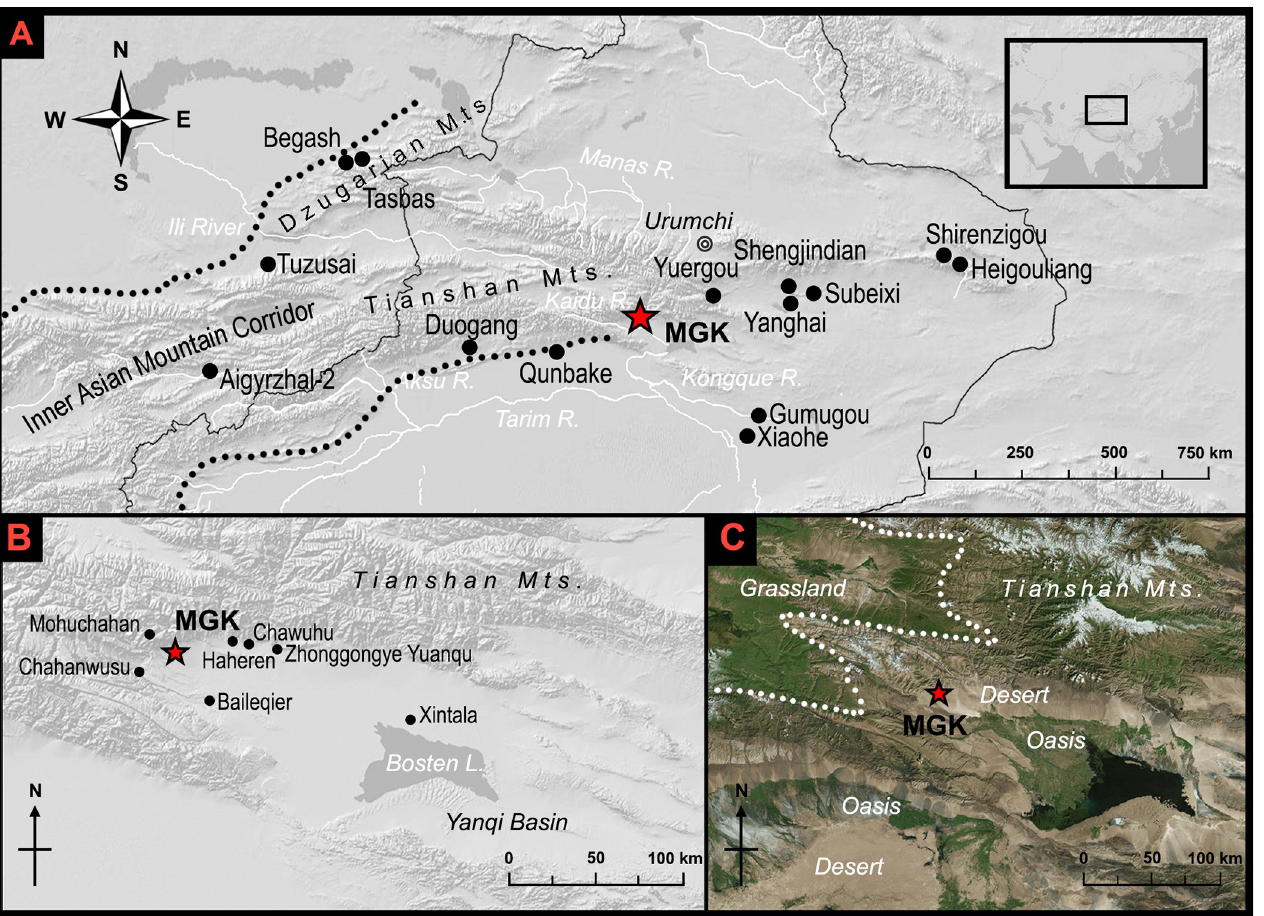
Fig 1. Location of MGK. (A) Location of MGK and other sites mentioned or cited in this article (except for those in the Yanqi Basin). (B) Important archaeological sites in the Yanqi Basin. (C) Ecozones in the Yanqi Basin